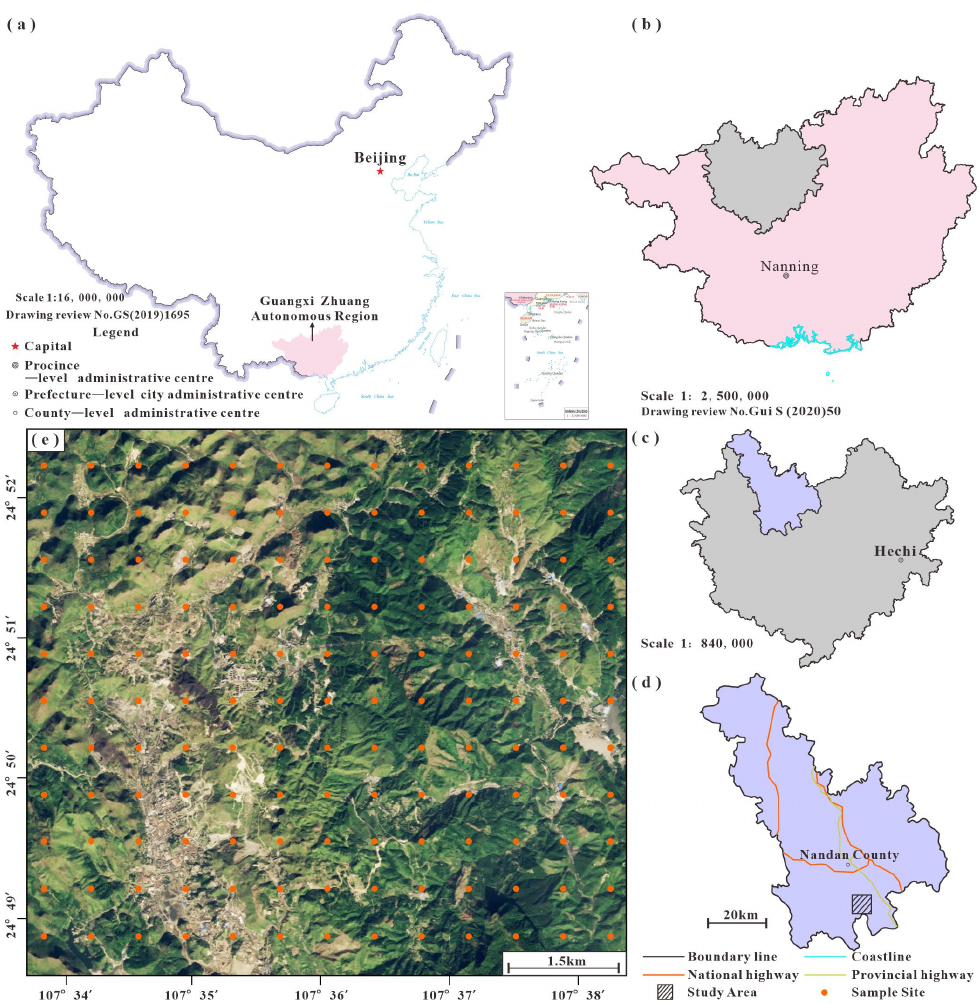
Figure 1. Location diagram of the study area in China and Guangxi ( a – d ) and distribution diagram of soil sampling ( e ). of soil sampling ( e